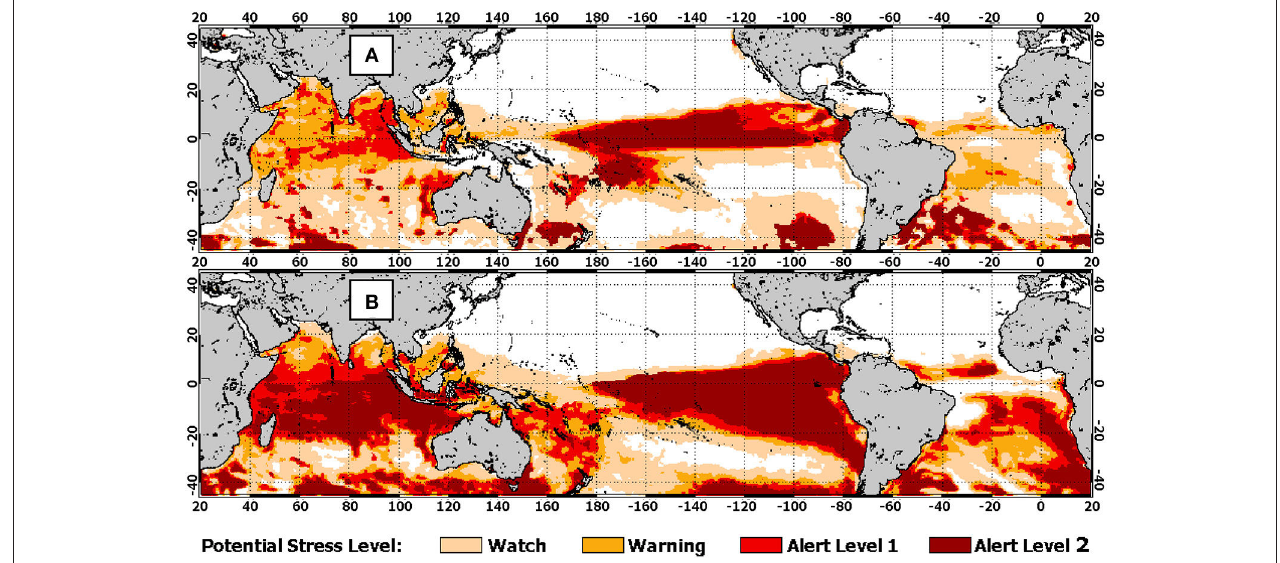
FIGURE 15 | CRW’s 4-Month Outlook (Version 3) of 60% probability (A) issued on March 3, 2015 for March-June 2015 and (B) on February 2, 2016 for February–May 2016. Long-lasting, continuous Alert Level 2 heat stress was predicted over islands and atolls in the central equatorial Pacific Ocean, including Kiritimati and Jarvis Islands, located at the epicenter of the extremely strong 2015-16 El